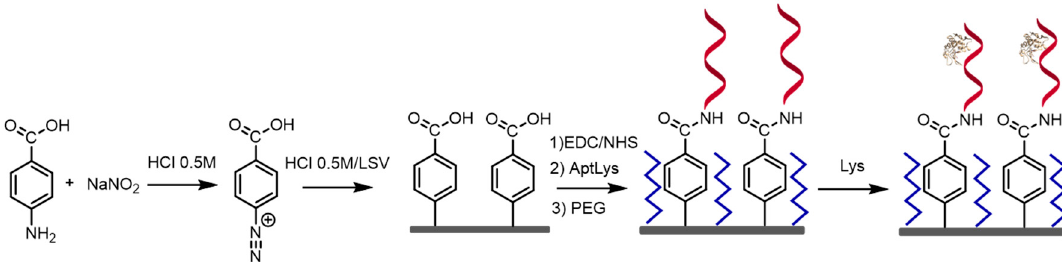
Figure 2. Steps for the experimental protocol for the label-free aptasensor for Lys detection based on covalent bond immobilization technique via electrochemical grafting.